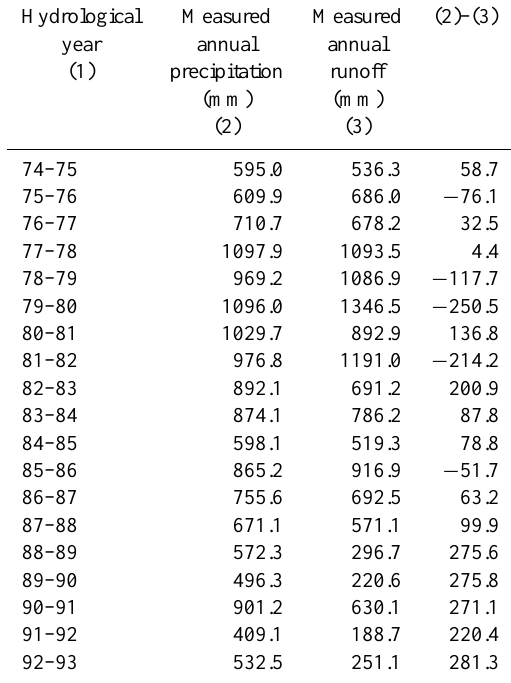
Table 1. Annual precipitation depths and river discharges per unit area of the basin at the location of the hydroelectric plant (HP, point A in Fig. 2) for the period 1 October 1974– 30 September